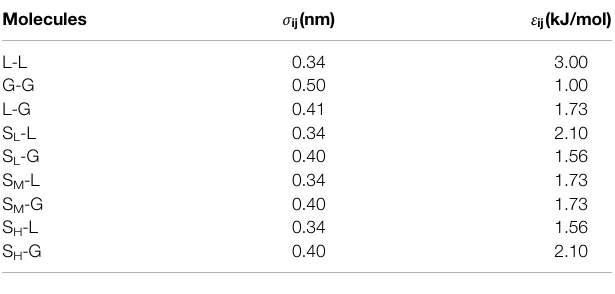
TABLE 1 | LJ parameters used in simulations. Molecules